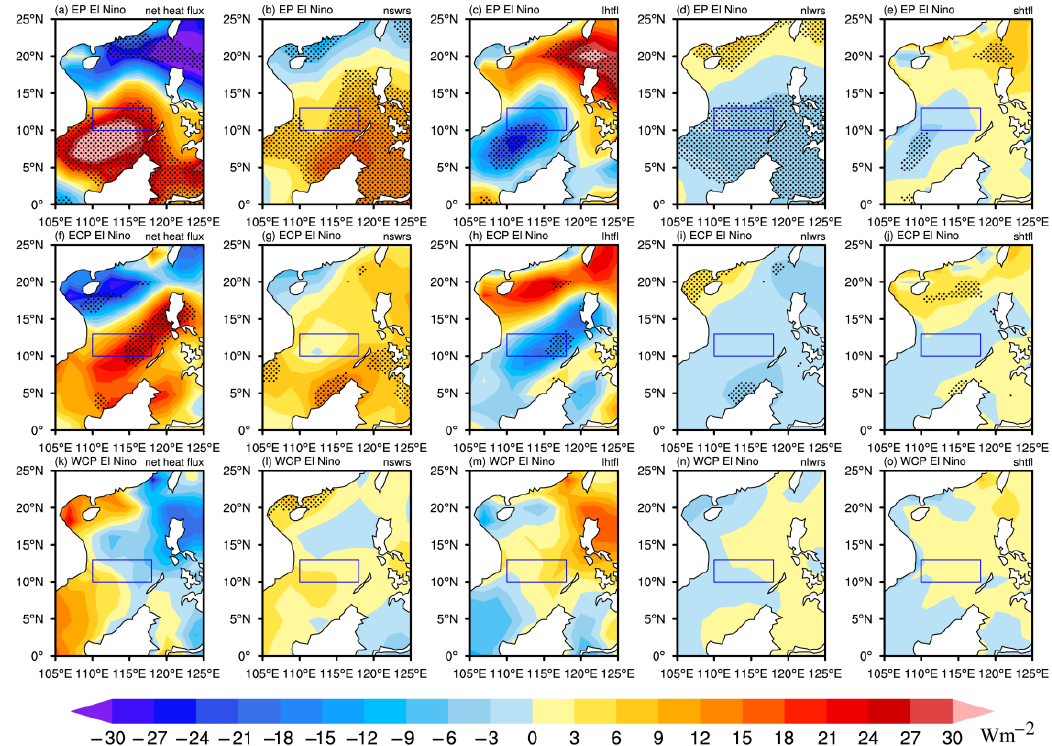
Figure 5. Composite DJF anomalies of net surface heat flux ( a , f , k ), short-wave radiation flux ( b , g , l ), latent heat flux ( c , h , m ), long-wave radiation flux ( d , i , n ) and sensible heat flux ( e , j , o ) (W · m − 3 ) over the SCS for EP El Niño ( a – e ), ECP El Niño ( f – j ) and WCP El Niño ( k – o ). The stippled areas represent the values exceeding the 90% significance level. Rectangles represent the CT region. Long-wave radiation, latent heat flux and sensible heat flux are upward positive and short-wave radiation is downward positive.